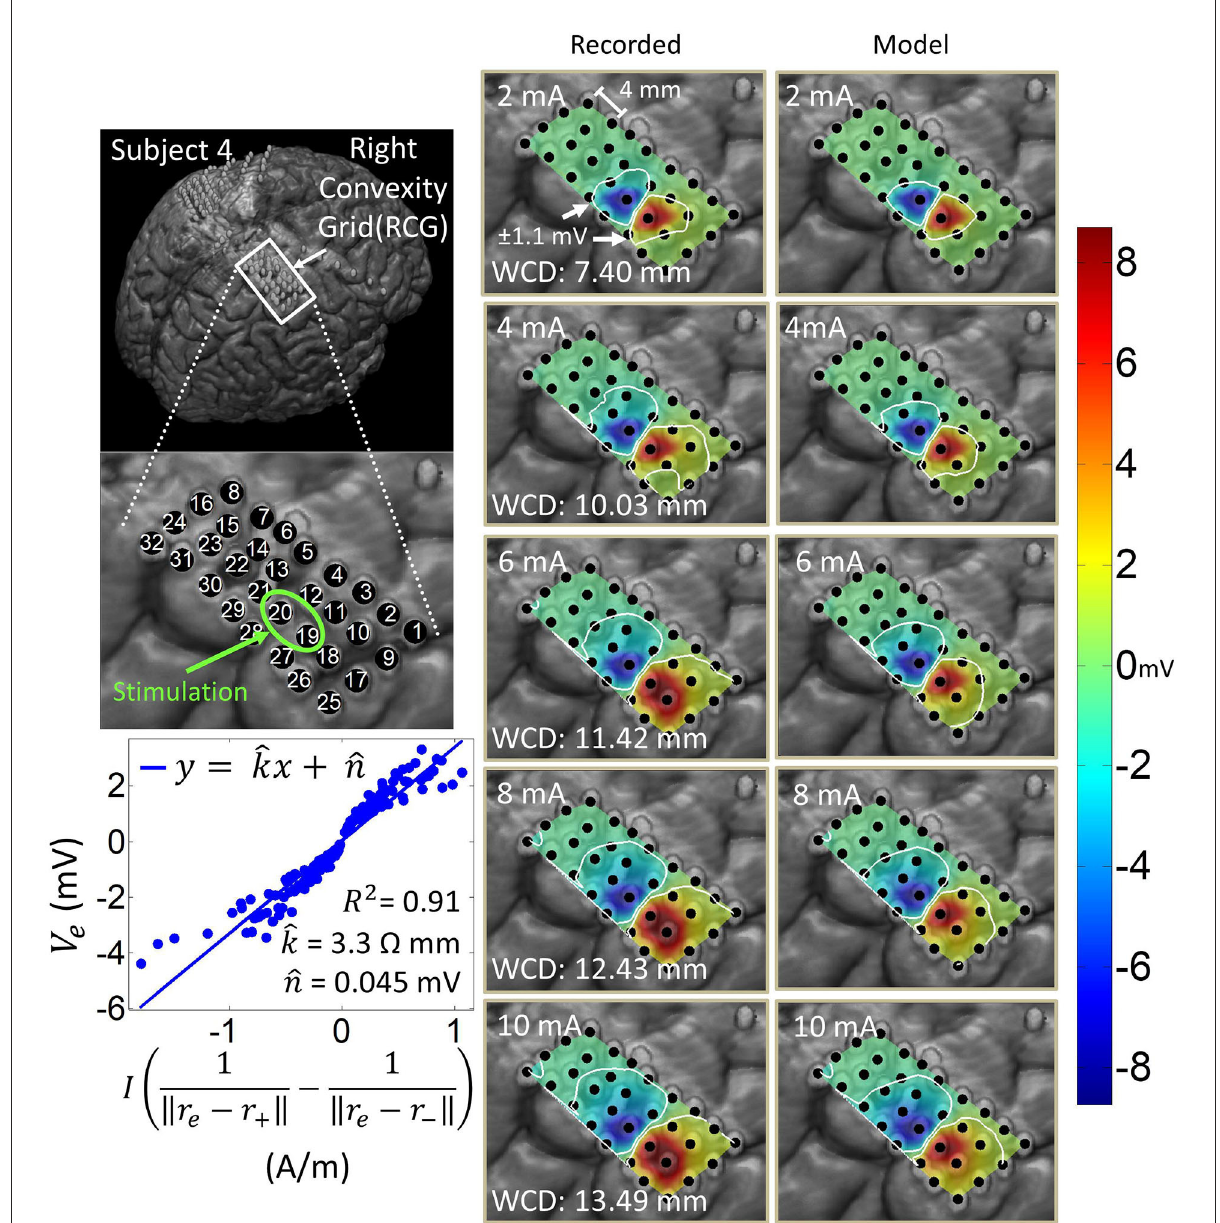
FIGURE8 Artifact spatial maps for recorded ECoG data and predicted data for subject 4. (Top left) Co-registration image showing the representative grid located over the right sensorimotor area. (Bottom left) Regression results for the stimulation channel RCG19-20 aggregating data from current amplitudes 2–10 mA. Artifact spatial maps were generated using values from the recorded data (middle) the dipole model (right) . Electrode RCG18 saturates at 6 mA and above, at which point it is excluded from the analysis as it no longer contains any ECoG